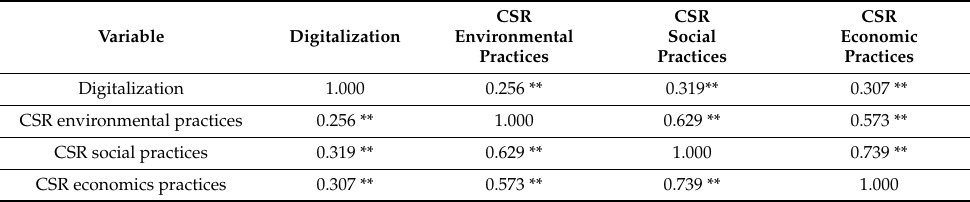
Table 4. Correlation analysis